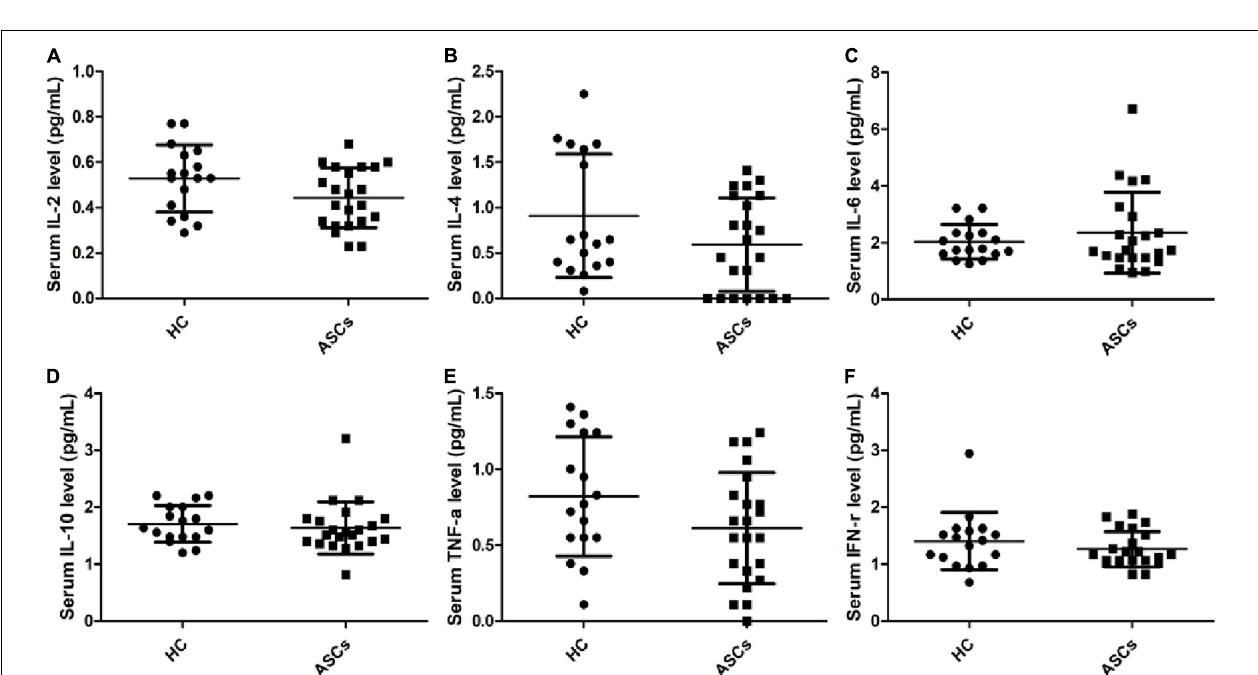
FIGURE 6 | Expression levels of six cytokines in serum from chronic ASCs. (A) The relative levels of IL-2. (B) The levels of IL-4. (C) The levels of IL-6. (D) The relative levels of IL-10. (E) The relative levels of TNF- α . (F) The relative levels of IFN- γ . Data represent the mean ± SD.